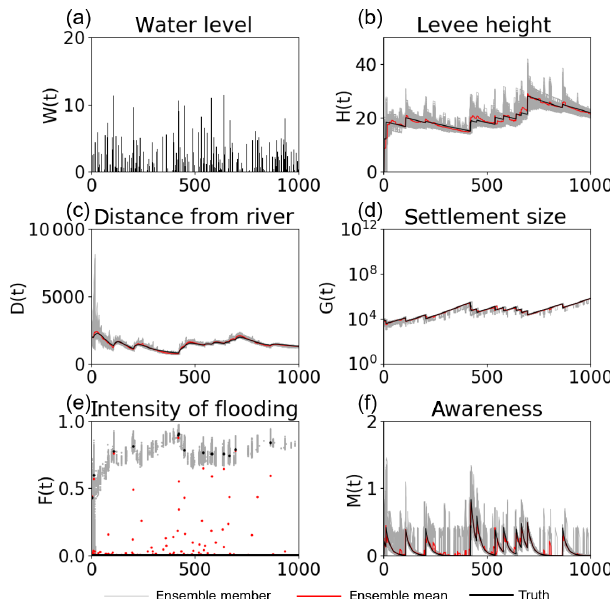
Figure 6. Time series of (a) the high water level W(t) , (b) the flood protection level (or levee height) H(t) , (c) the distance of the center of the mass of the human settlement from the river D(t) , (d) the size of the human settlement G(t) , (e) the intensity of flooding events F(t) , and (f) the social awareness of the flood risk M(t) simulated by the data assimilation experiment in which the observations of F , G , D , H , and M are assimilated into the model every 10 years, with 5000 ensembles, in experiment 2 (see Sect. 3.1.2). The time step is annual. Gray, red, and black lines are the ensemble members, their mean, and the synthetic truth, respectively.